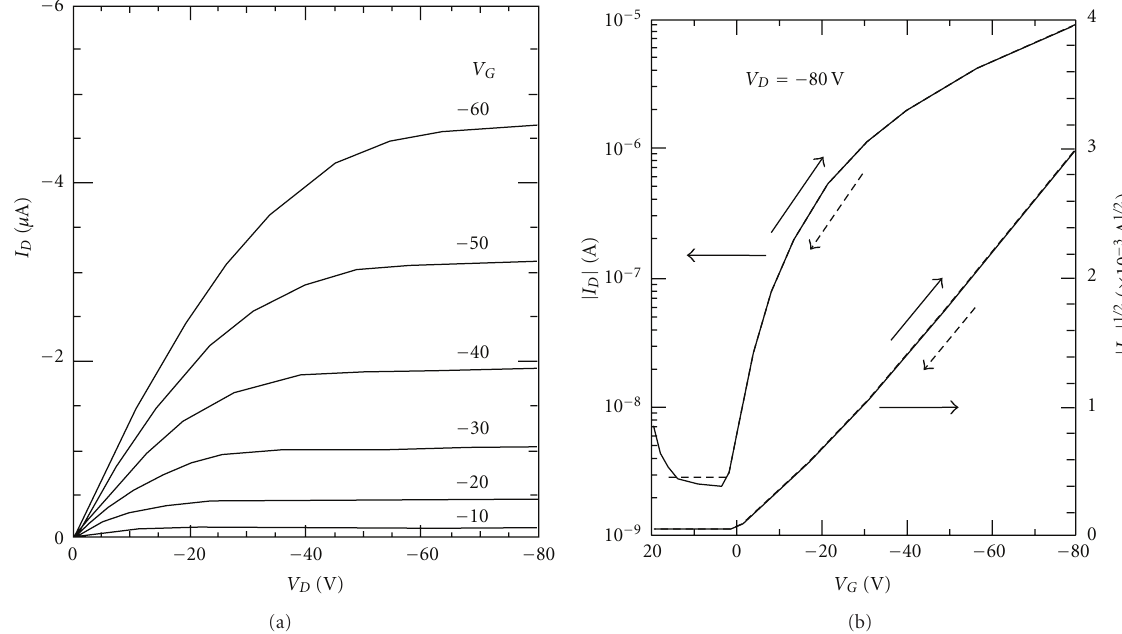
Figure 7: (a) Output and (b) transfer characteristics of P3HT TFT with PMSQ gate insulator.